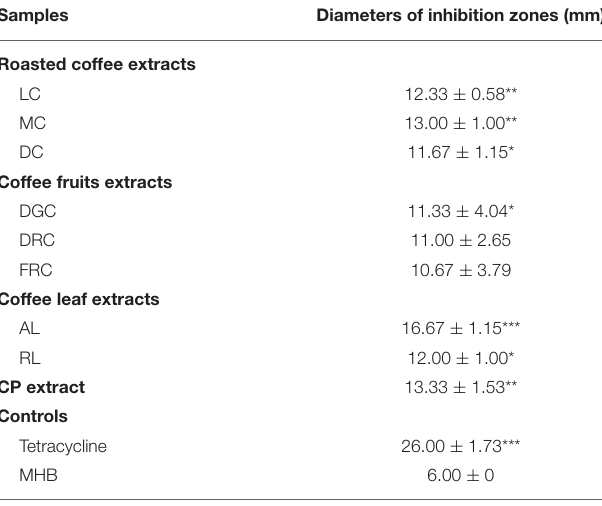
TABLE 2 | Diameters of inhibition zones obtained with coffee beans and coffee by-products at 500 mg/mL on the 7th pandemic V. cholerae O1 El Tor N16961 strain.